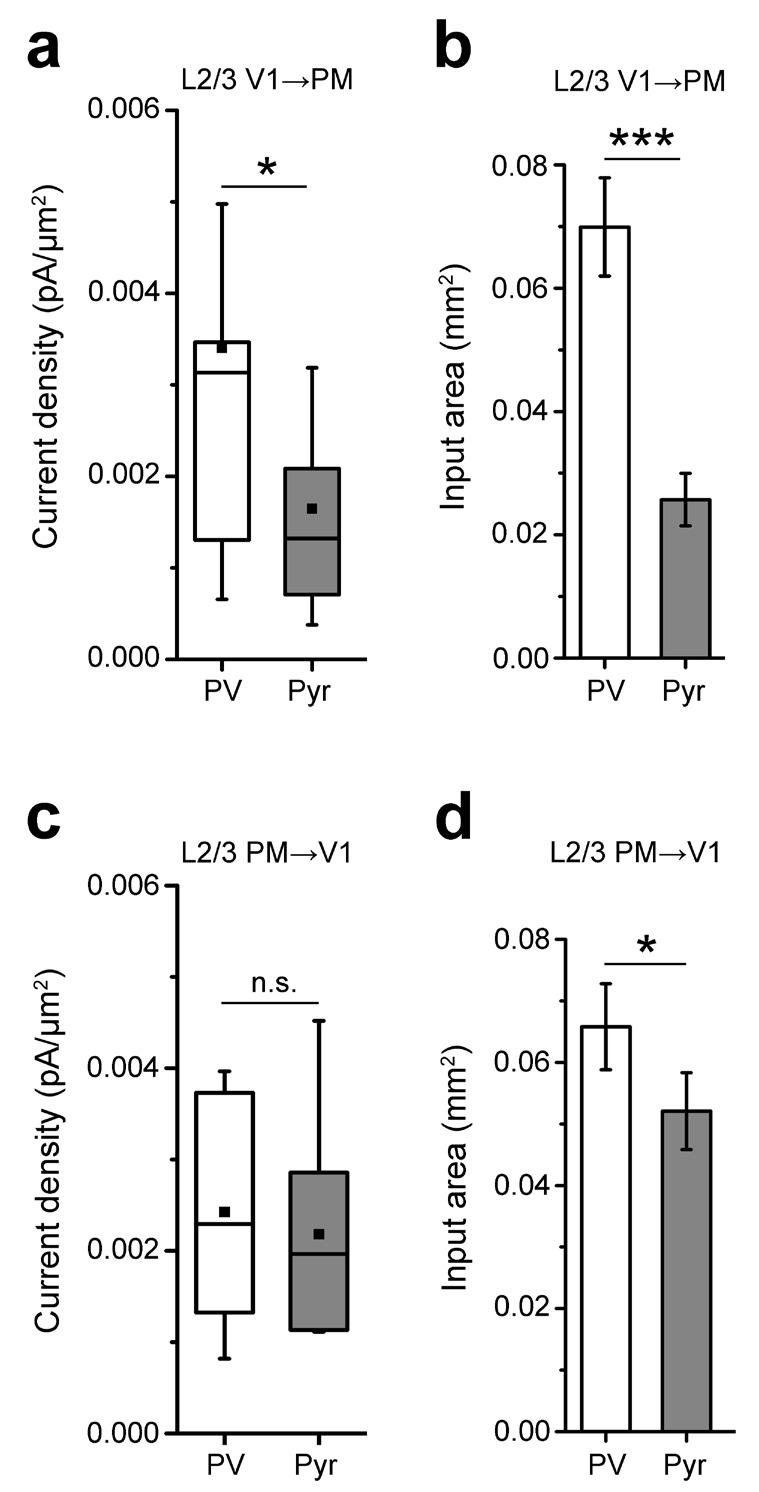
Analyses of inputs to L2/3 PV and Pyr neurons in the reciprocal pathways between V1 and PM.(a) The EPSC per 75 × 75 µm pixel, calculated as pA/µm (2), is larger in PV than in Pyr cells in FFV1→PM. (b) Individual PV cells receive interareal FFV1→PM input over a larger area than Pyr cells (***p<0.001). (c) The EPSC per pixel in PV and Pyr cells is not significantly different in the FBPM→V1 pathway. (d) PV cells receive input over a larger area than Pyr cells in the FBPM→V1 pathway (*p<0.05).